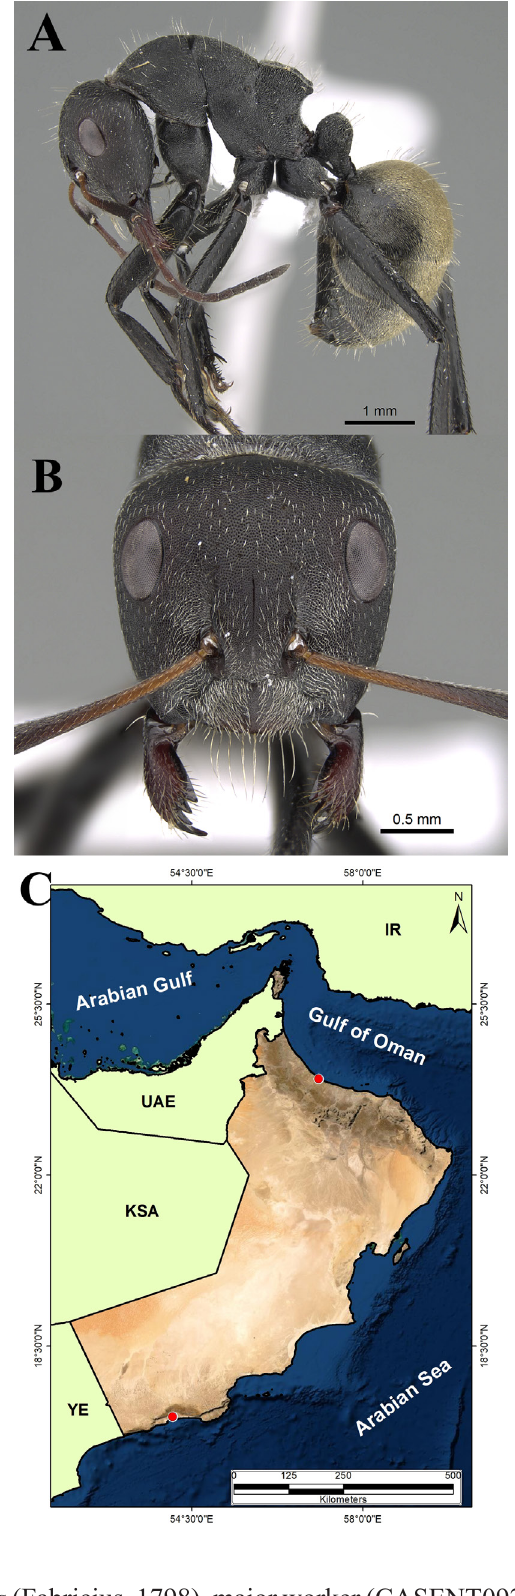
Fig. 8. Camponotus sericeus (Fabricius, 1798), major worker (CASENT0922266, AntWeb.org (Michele Esposito)). A . Body in profile. B . Head in full-face view. C . Distribution